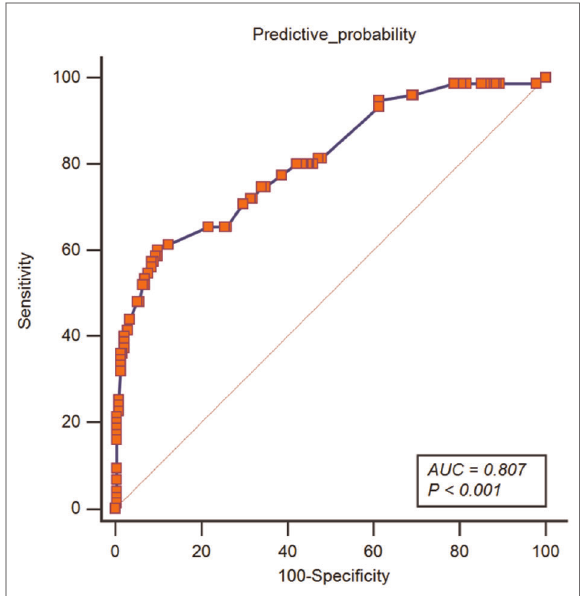
FIGURE 5 Calibration curves of the prolonged PLOS prediction in the cohort. The x -axis represents the predicted prolonged PLOS risk. The y - axis represents the actual diagnosed prolonged PLOS. The diagonal dotted line represents a perfect prediction by an ideal model. The solid line represents the performance of the nomogram, of which a closer fi t to the diagonal dotted line represents a better